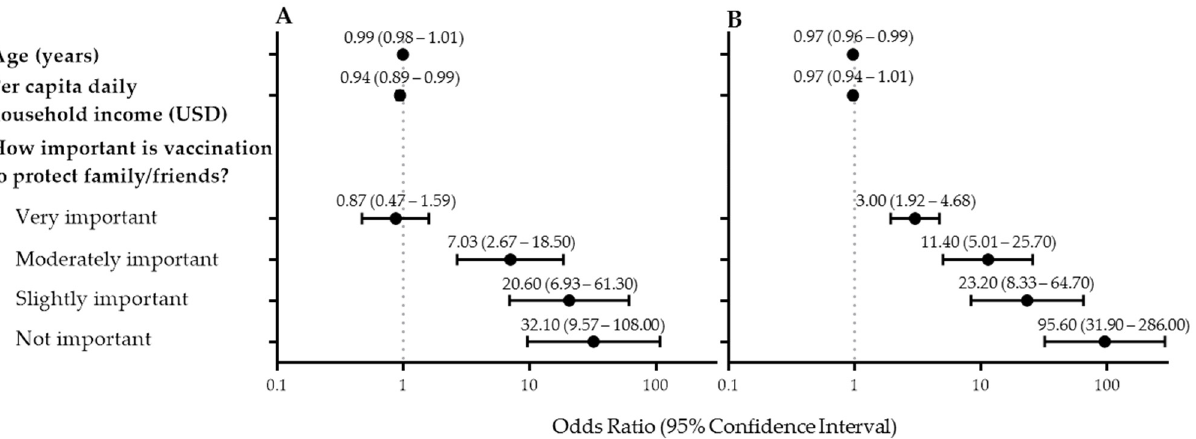
Figure 2. Multinomial regression model of factors associated with COVID-19 vaccine hesitancy. ( A ) Not Sure vs. Yes ( B ) No vs. Yes.